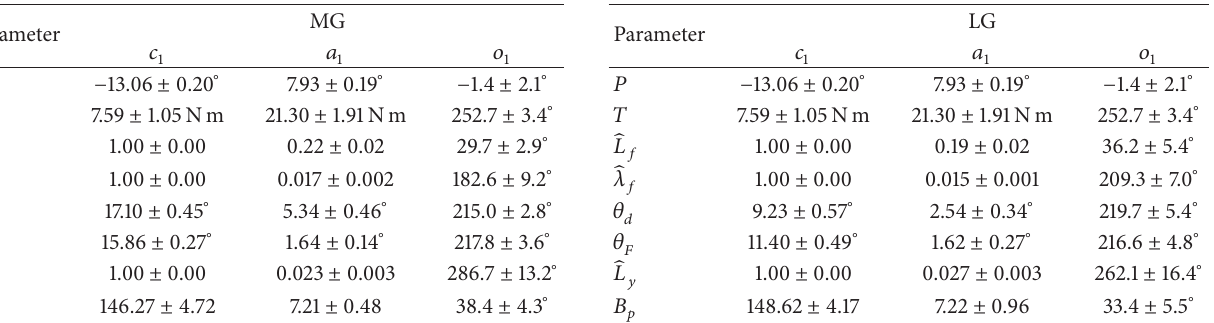
Table 1: Fourier coefficients for the medial gastrocnemius. Table 2: Fourier coefficients for the lateral